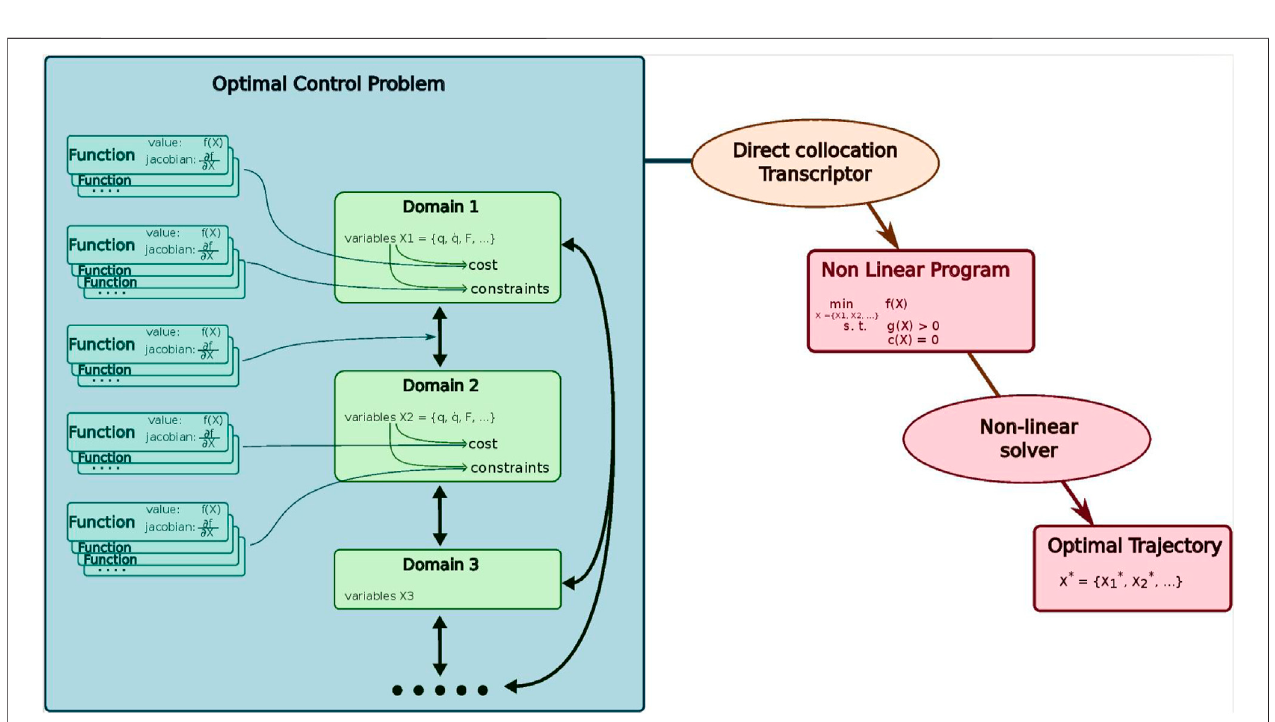
FIGURE 9 | Architecture of our direct collocation